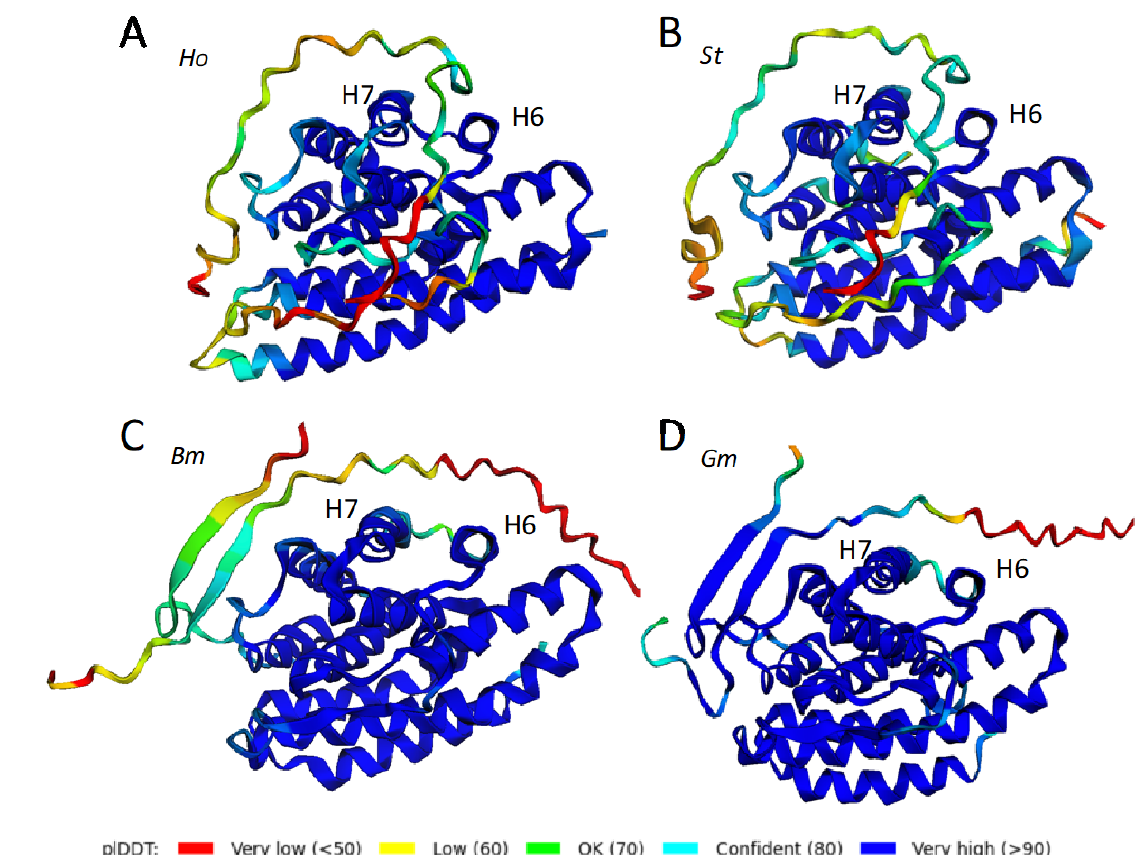
Figure 5. Heteroduplex structures: L-fibs with corresponding H-fib C-termini from the same species. ( A ) H . occidentallis ( Ho ). ( B ) S. tienmushanensis ( St ). ( C ) B . mori ( Bm ). ( D ) G . mellonella ( Gm ). The chains were colored using the Colabfold-generated per residue pLDDT confidence score.